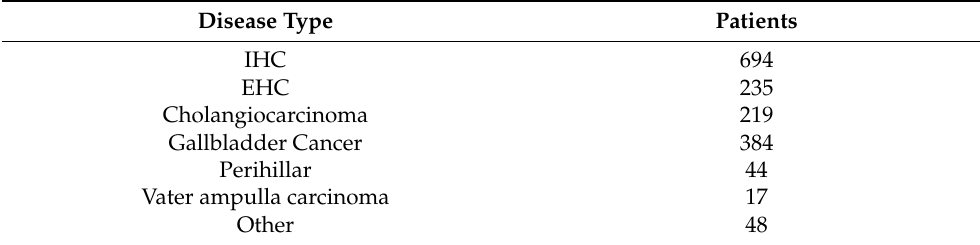
Table 3. Primary target sites of targeted-therapy studies.